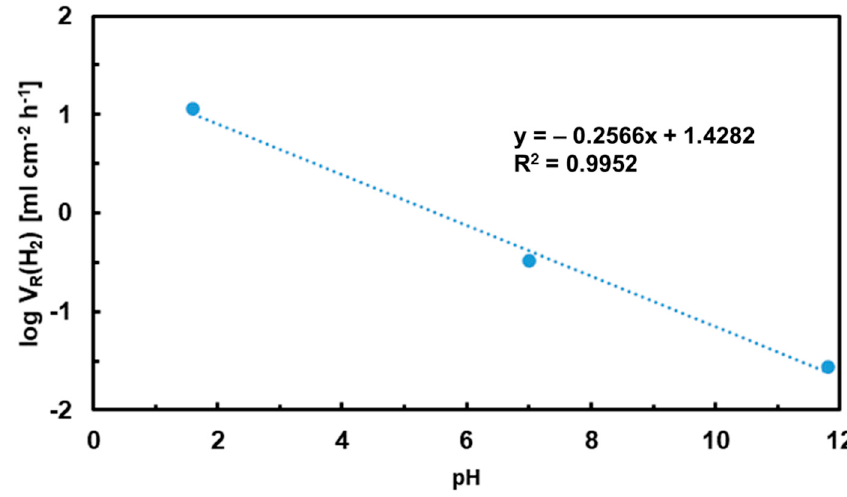
Figure 4. Hydrogen evolution rates of the as-cast Mg 2 Sn alloy as a function of the pH of the electro- lyte.